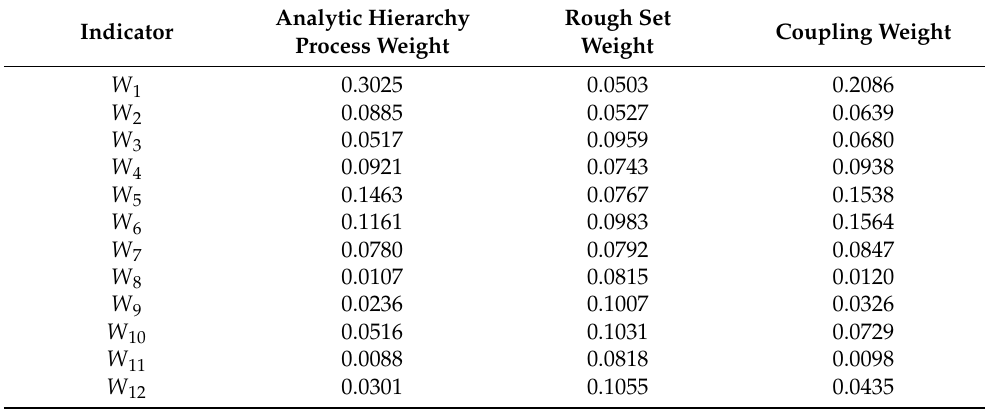
Table 8. Evaluation index coupling